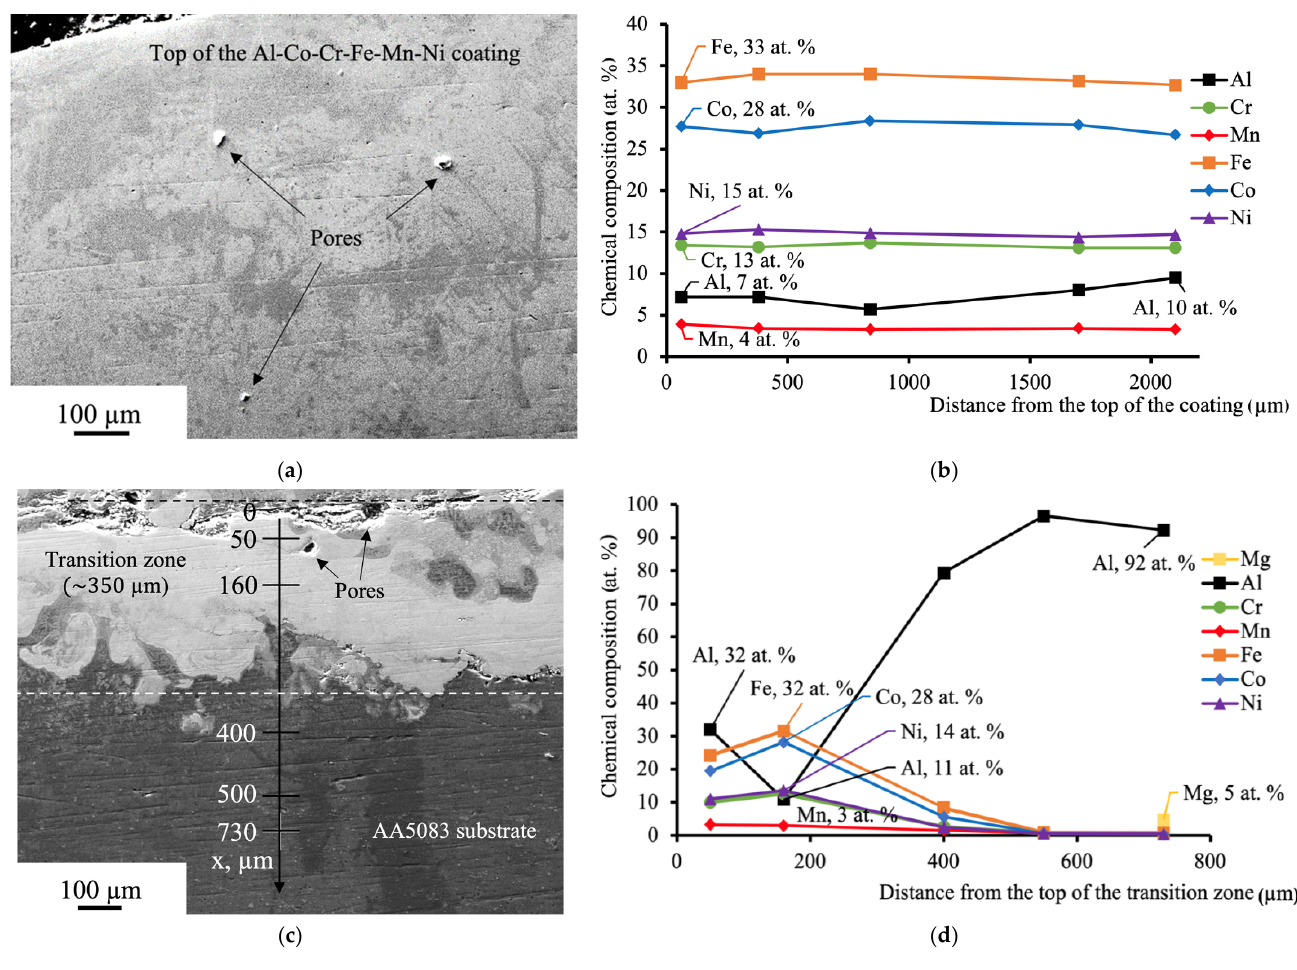
Figure 1. ( a ) SEM of the Al-Co-Cr-Fe-Mn-Ni HEA coating; ( b ) the results of EDS analysis accom- plished from the top of the coating; ( c ) SEM of the transition zone between the coating and the substrate. The distances from the top of the transition zone in which EDS analysis was carried out are marked on the axis; ( d ) the results of EDS analysis alongside the axis indicated in ( c ).